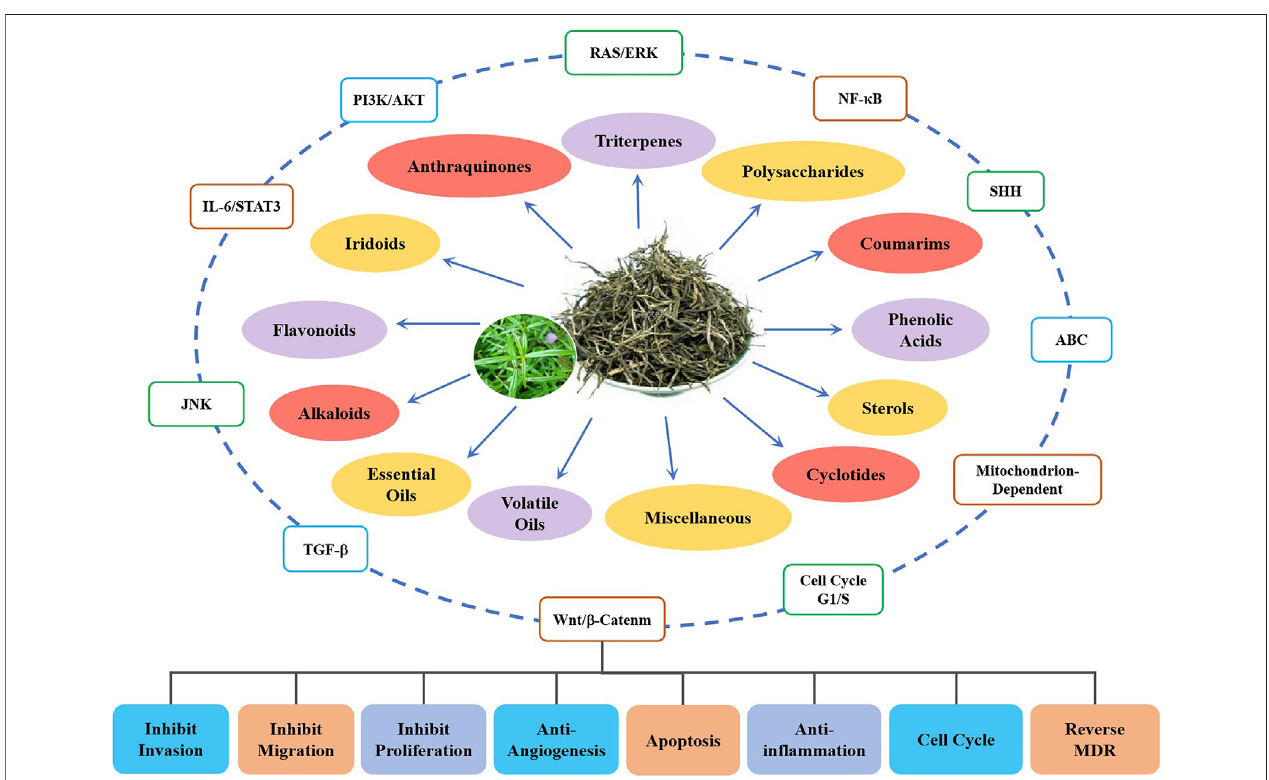
FIGURE 3 | Schematic diagram of anti-colorectal cancer components from HDW and their related mechanisms.